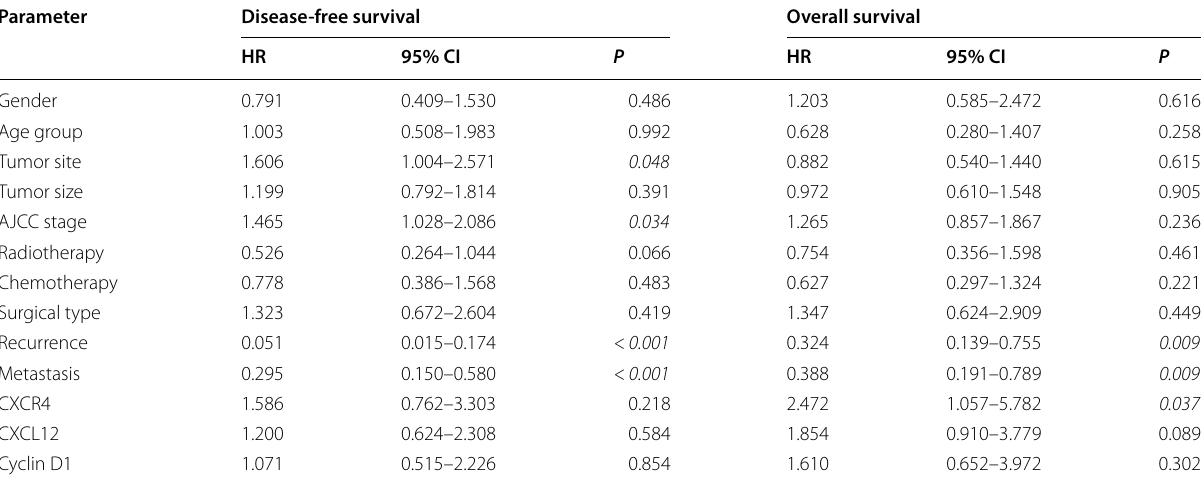
Table 2 Univariate analysis of the prognostic values of clinicopathologic characteristics and protein expression in spo- radic MPNST patients